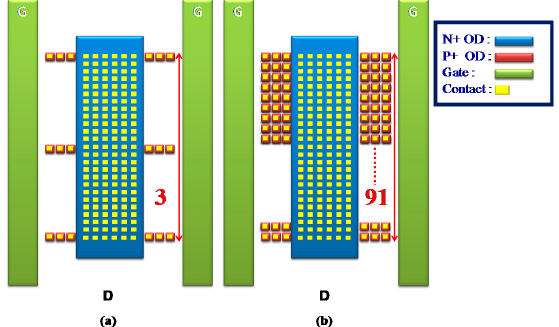
Figure 4. Schematic diagram of an nLDMOS-SCR ( p-n-p -arranged and discrete-anode type): ( a ) DIS_3 and ( b ) DIS_91.